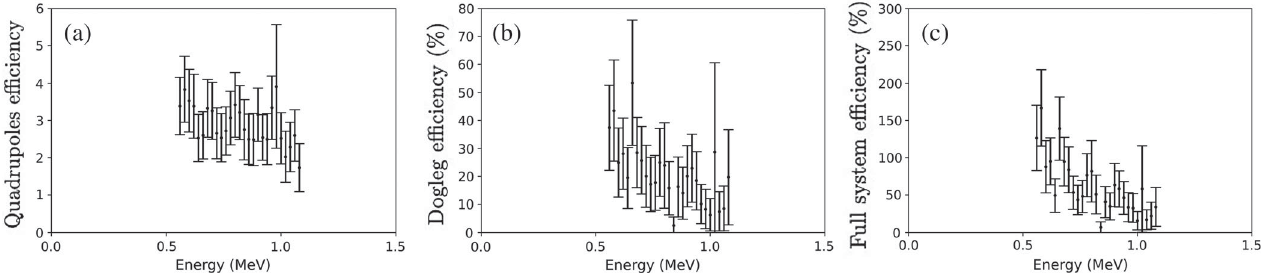
FIG. 7. Simulated results of the (a) the ratio between the positron with (blue dashed line in Fig. 6) and without (black solid line in Fig. 6) the Hallbach magnets, (b) the ratio between the positron spectrum with (red dotted line in Fig. 6) and without (blue dashed line in Fig. 6) the second dipole magnet in the dogleg, and (c) the ratio between the positron spectrum after the whole system (red dotted line in Fig. 6) and the positron spectrum recorded without second dipole or Hallbach magnets (black solid line in Fig.